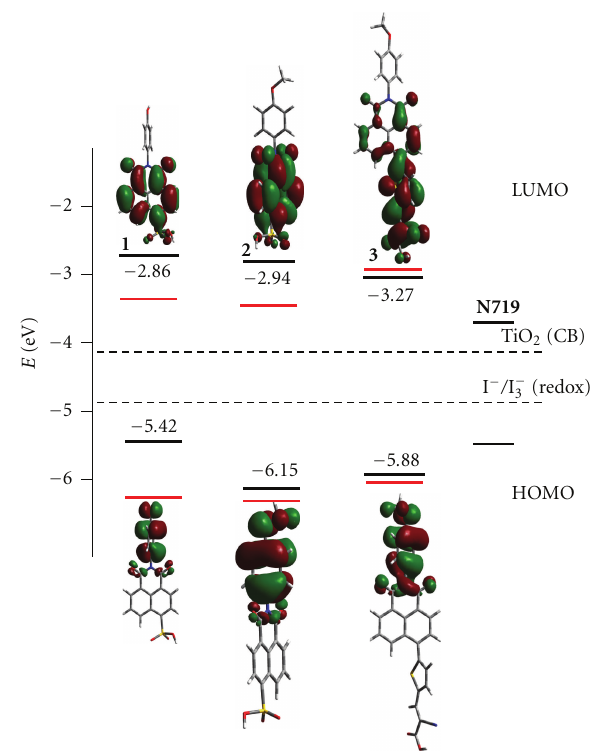
Figure 3: Energy diagram of TDDFT calculation indicates HOMO and LUMO orbitals of three sensitizers, adapted from [44].